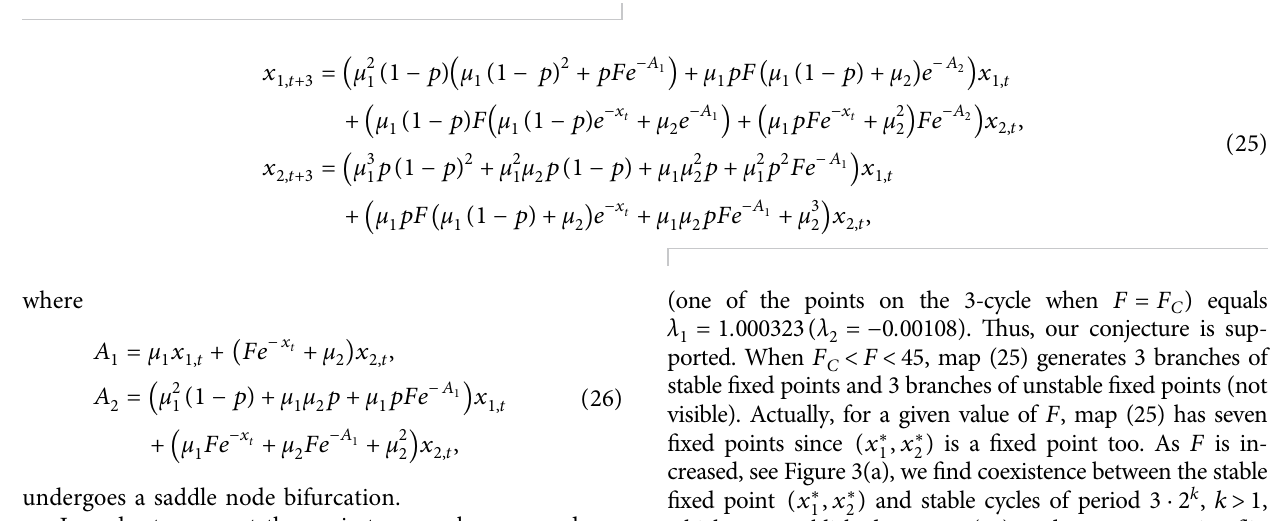
, μ , p ) � ( 0 . 05 , 0 . 1 , 0 . 2 ) 1 2